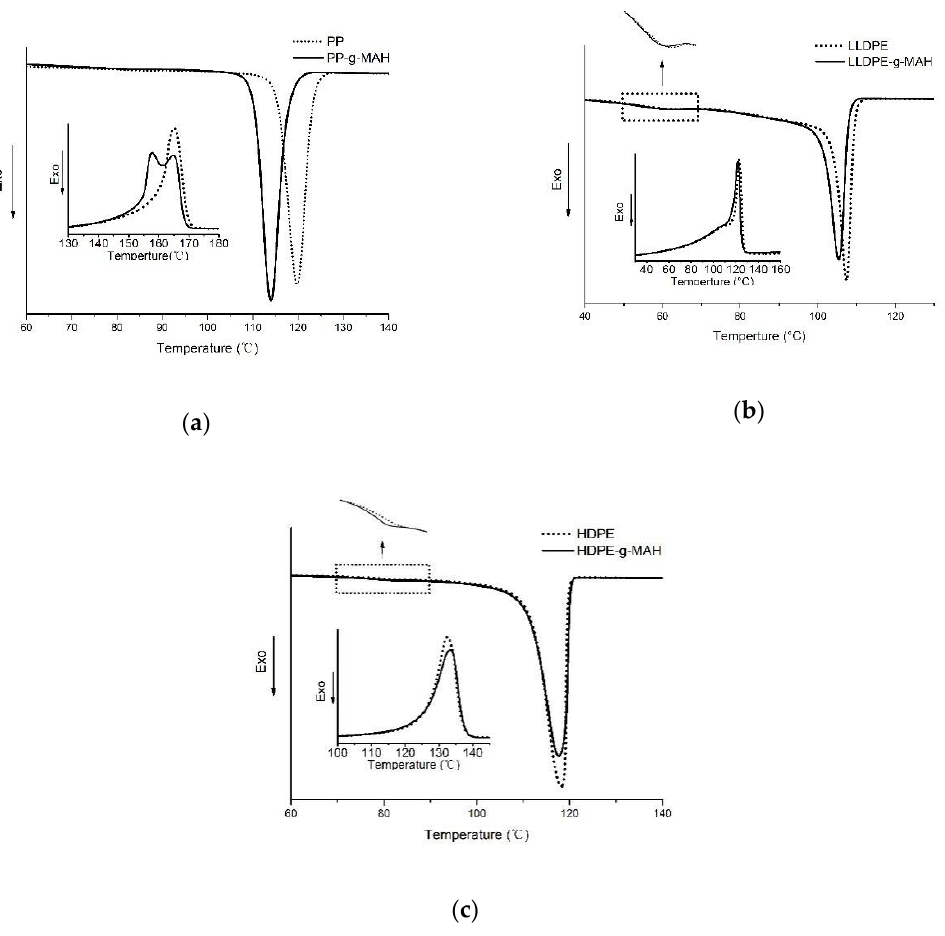
Figure 1. DSC scans of PP and PP- g -MAH ( a ), LLDPE and LLDPE- g -MAH ( b ), HDPE and HDPE- g -MAH ( c ).